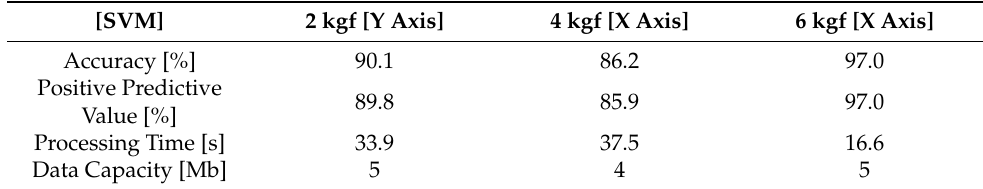
Table 8. Printing roll eccentricity diagnosis based on raw data (i.e., Sensors 1, 2, and 3).